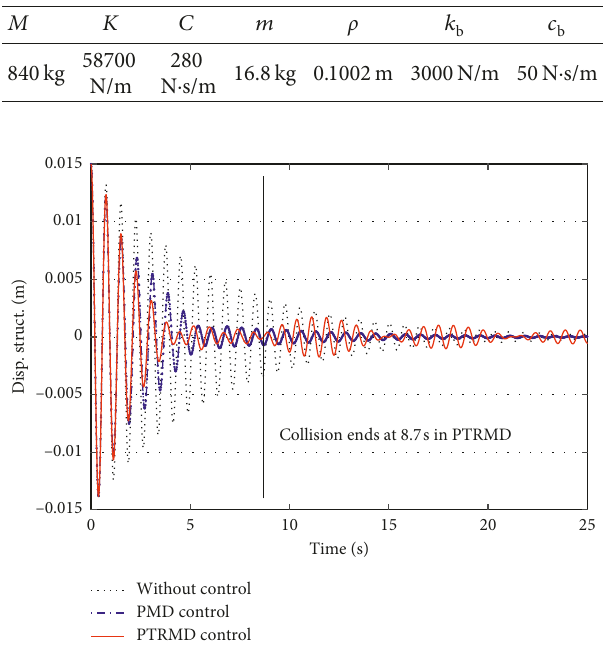
Figure 4: Free decaying displacement of the uncontrolled structure and the controlled structure with PMD and PTRMD.